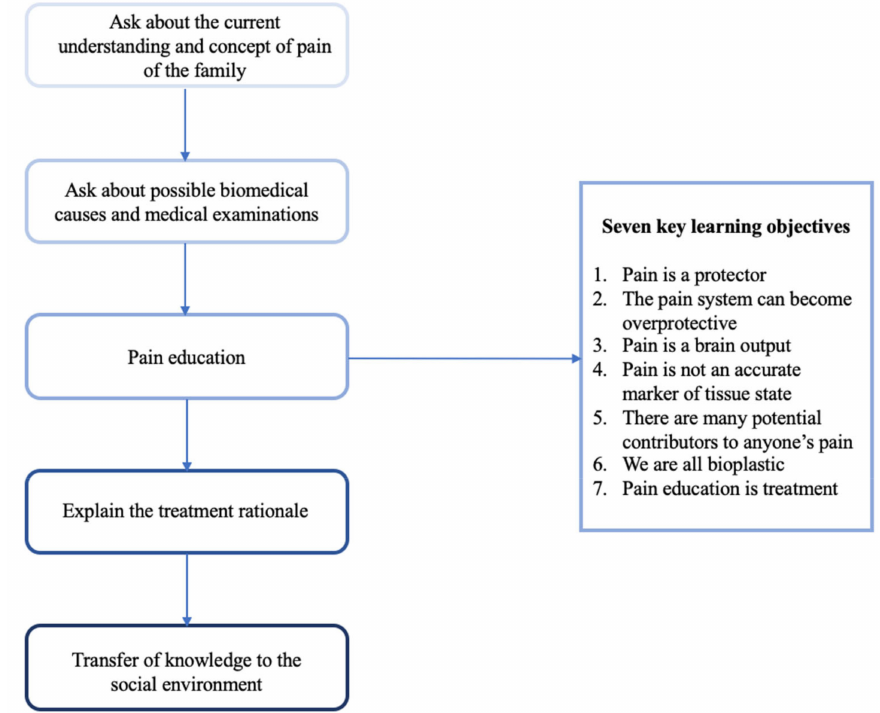
Figure 2. Flow chart: five suggested discussion points in clinical